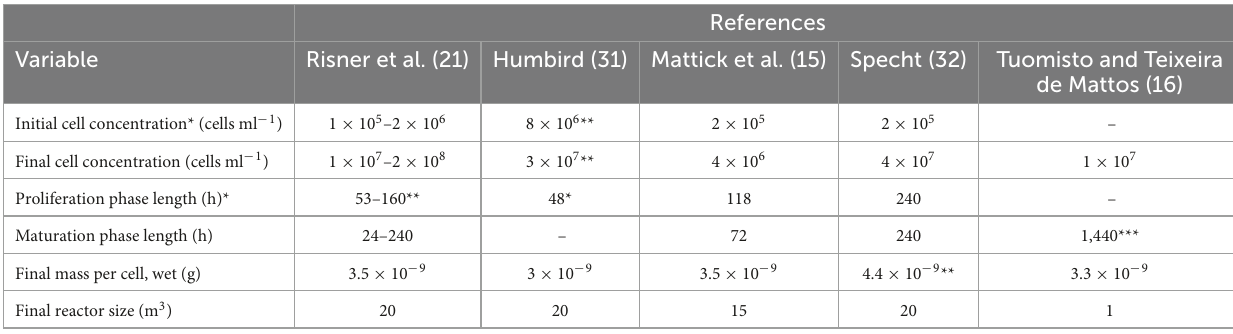
TABLE 1 A comparison of CM production assumptions applied or provided in several modeling